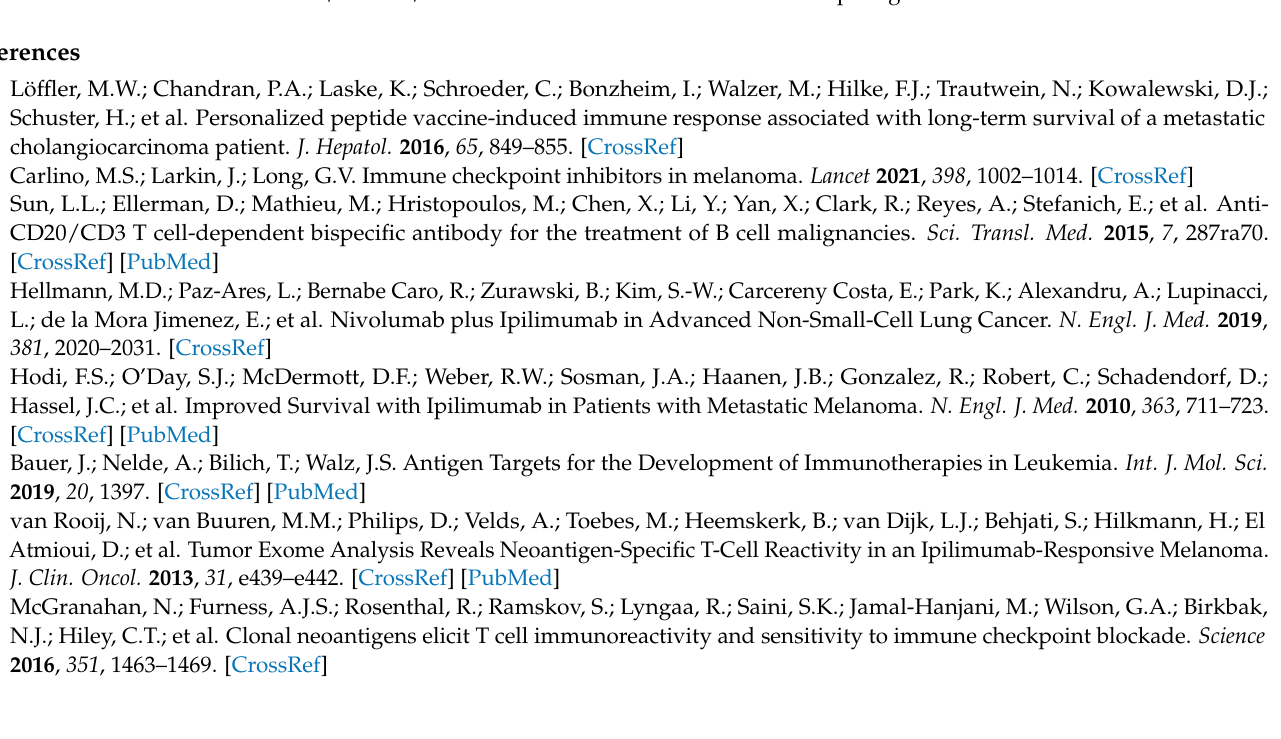
Figure S1: Correlation between amount of tumor tissue and peptide identifications within the immunopeptidome; Figure S2: HLA presentation of tumor-associated antigenic peptides according to different clinical parameters; Figure S3: Impact of MSLN gene expression on clinical outcomes; Figure S4: Impact of HLA class I gene expression on clinical outcomes; Figure S5: Impact of HLA class II gene expression on clinical outcomes. Table S1: HLA class I- and HLA class II-restricted OvCa-associated antigens. Supplementary Data S1: In silico prediction of the 62 MSLN-derived peptides to HLA class II